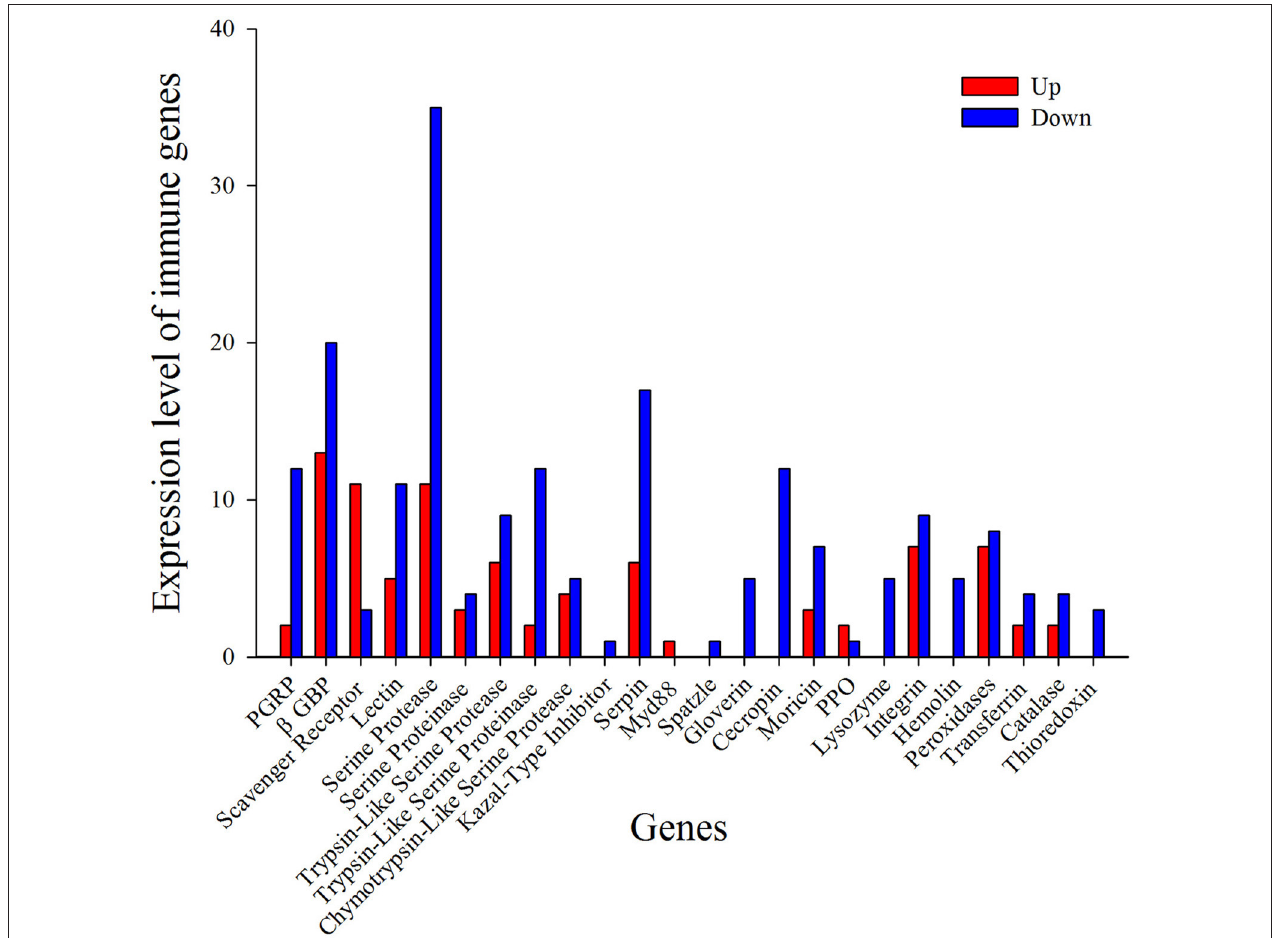
FIGURE 6 | Functional classification of immunity- related DEGs in response to I.